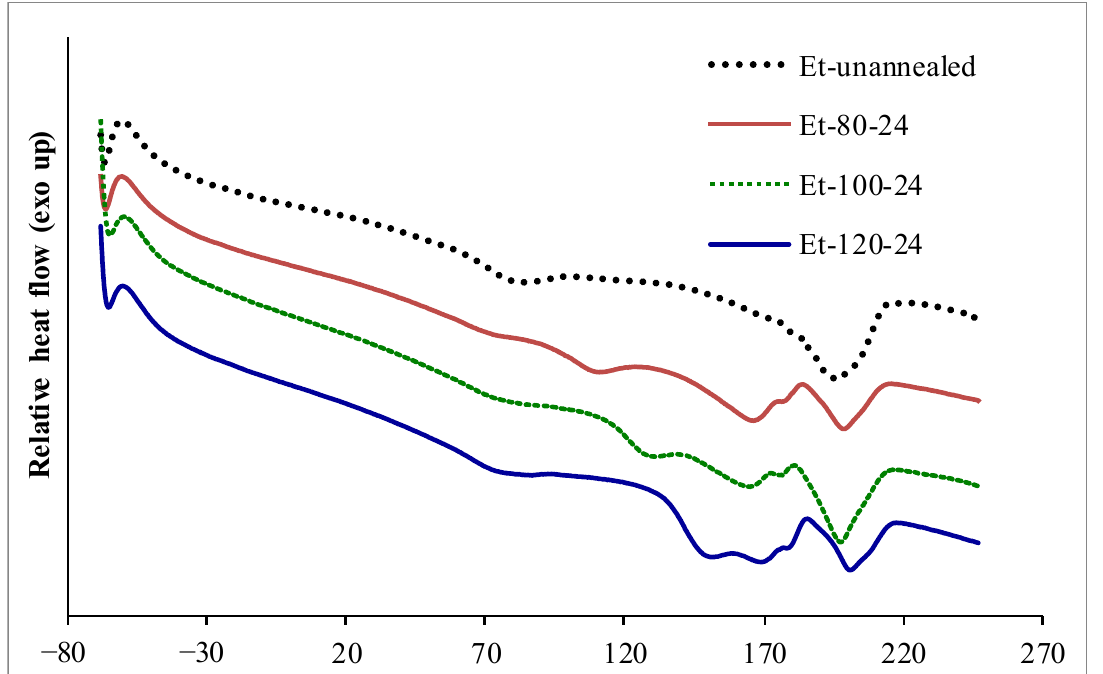
Figure 1 . DSC thermographs of PU - Ester / MWCNT nanocomposites annealed under different Figure 1. DSC thermographs of PU-Ester/MWCNT nanocomposites annealed under different conditions. conditions .